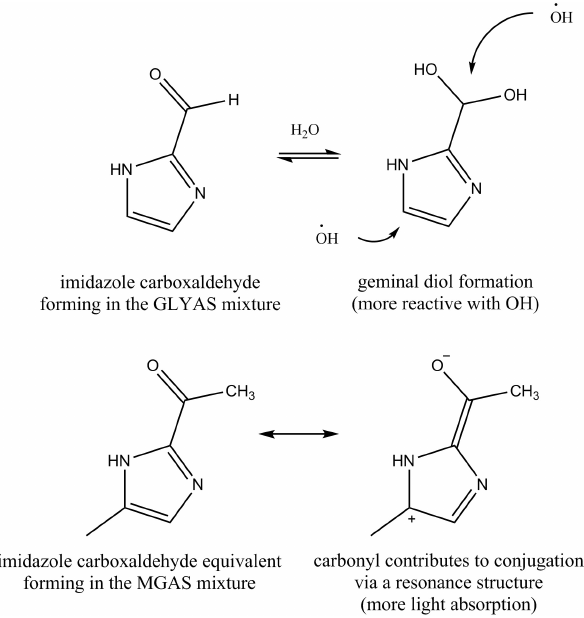
Figure 5. Proposed explanation for the difference in the major bleaching processes of the GLYAS and MGAS solutions.